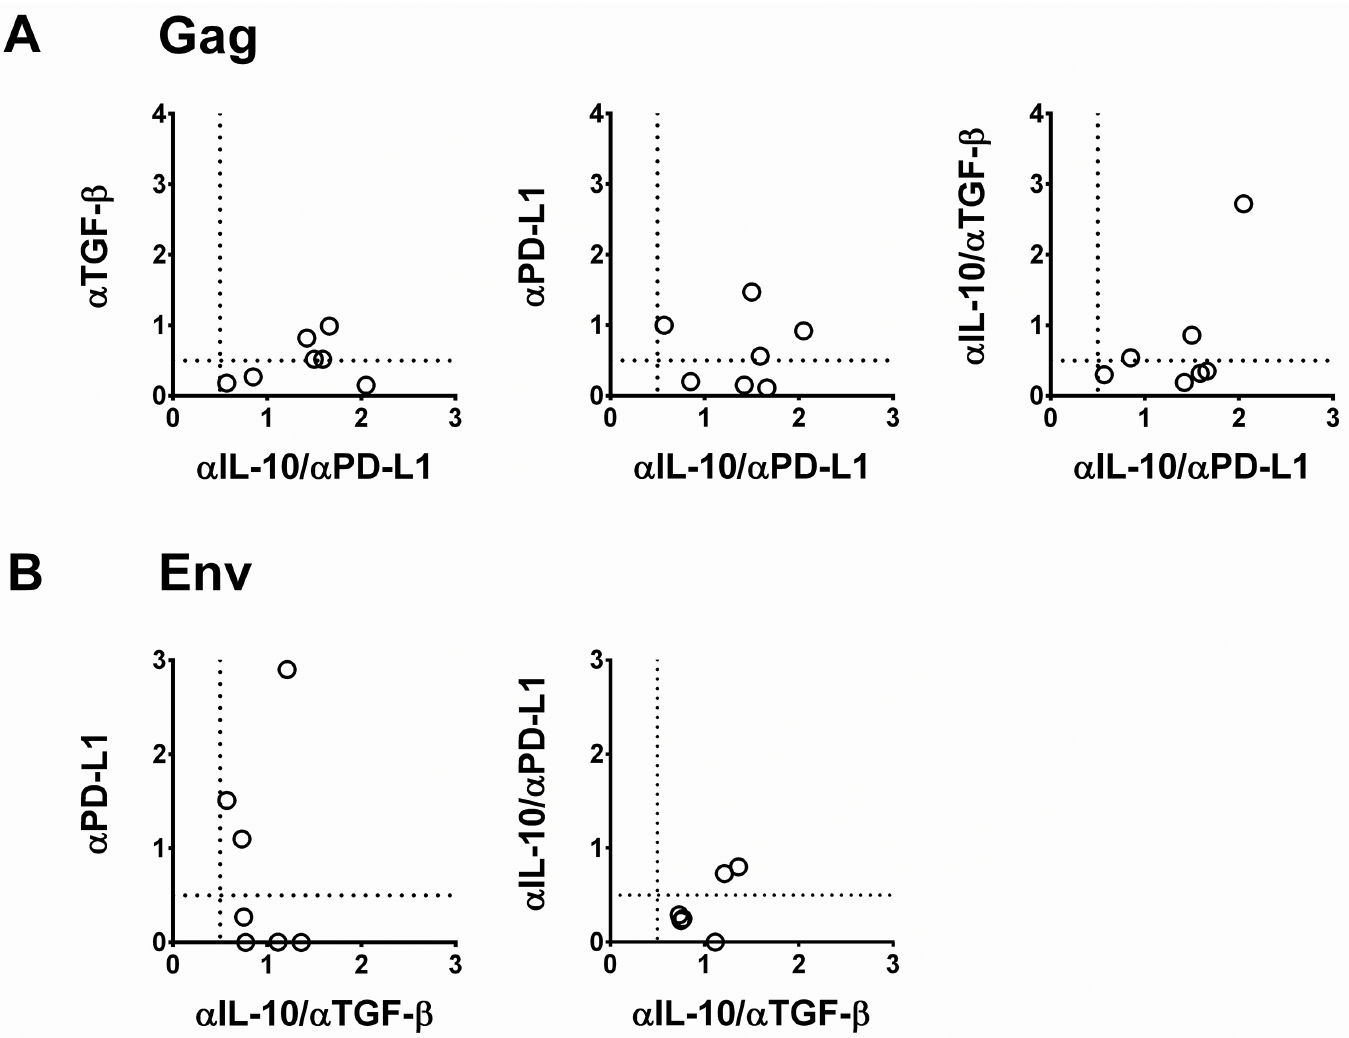
Fig 2. Gag and Env FTR is best identified by different combinations of blocking mAbs. The relationship between FTR mediated by various pathways in (A) Gag- and (B) Env-stimulated cultures. Plots include patients with detectable FTR on one or both axes. Only dual blockade of IL-10/PD-L1 (x-axis) identifies all patients with Gag FTR whereas dual blockade of IL-10/TGF- β (x-axis) identifies all patients with Env FTR. FTR defined as an increase in proliferating cells above a threshold of 0.5% (dashed